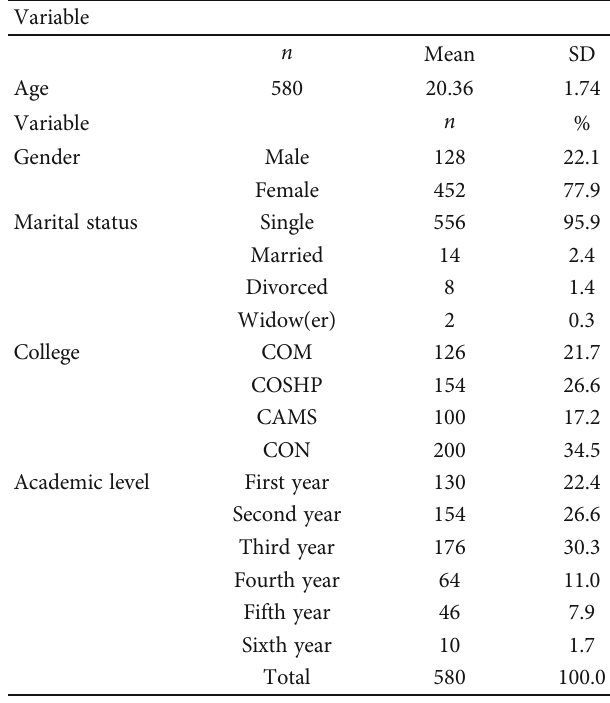
Table 1: Sociodemographic data of the participants ( n = 580